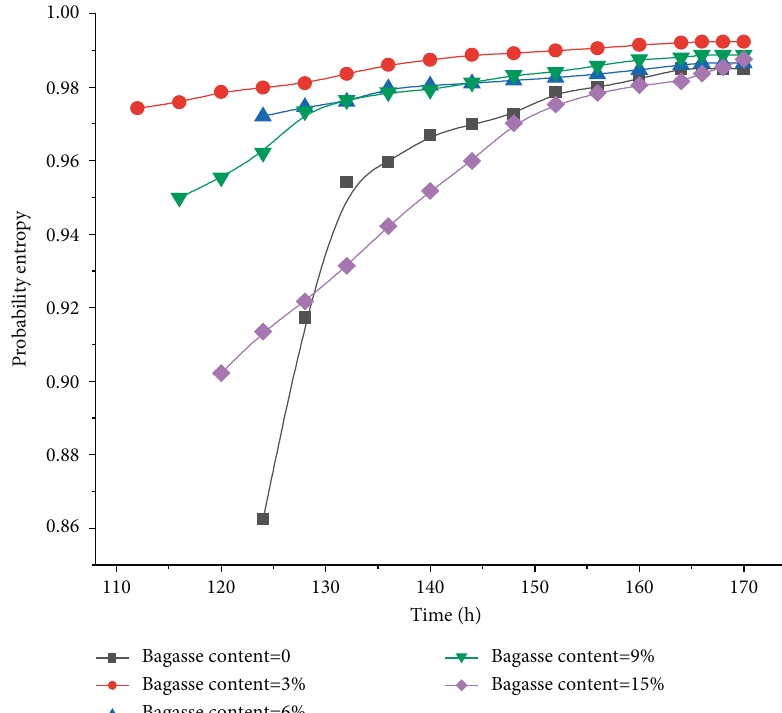
Figure 6: Change characteristics of clay crack entropy with different bagasse